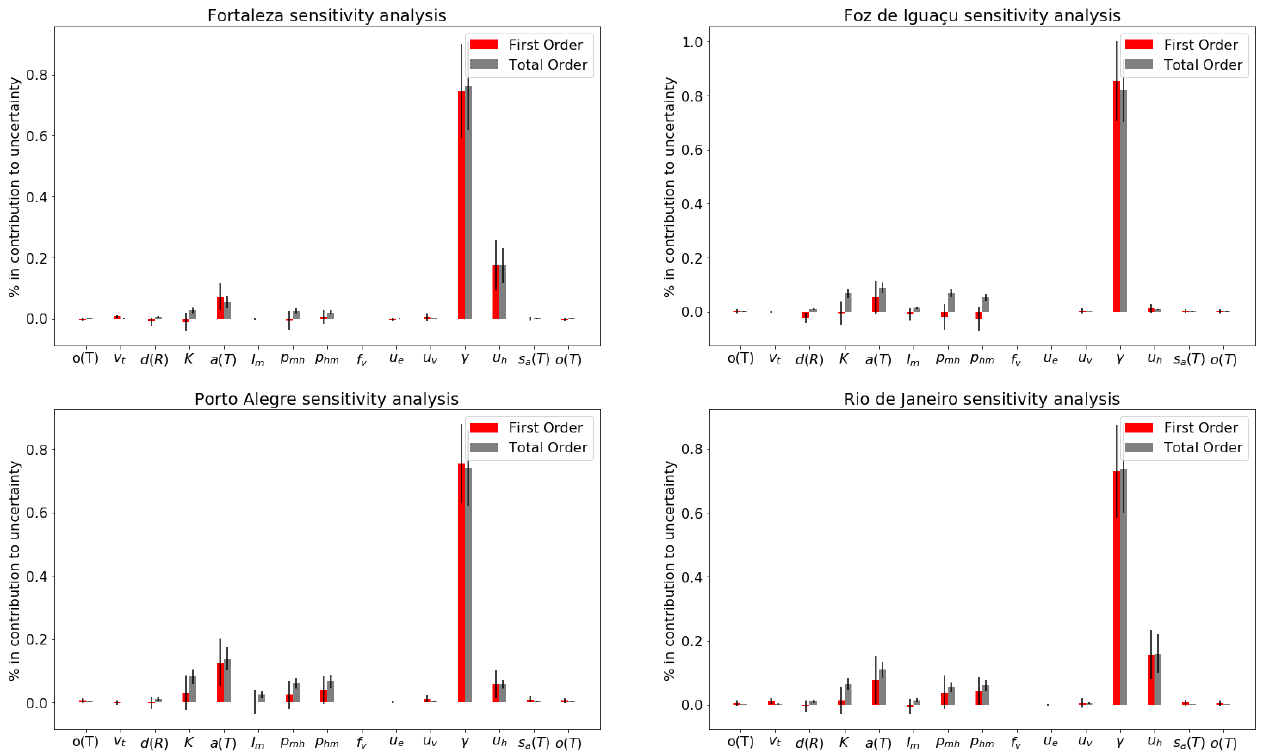
Figure 3. Sensitivity analysis for each model parameter. From top to bottom, from left to right: Fortaleza, Foz do Iguaçu, Porto Alegre and Rio de Janeiro.